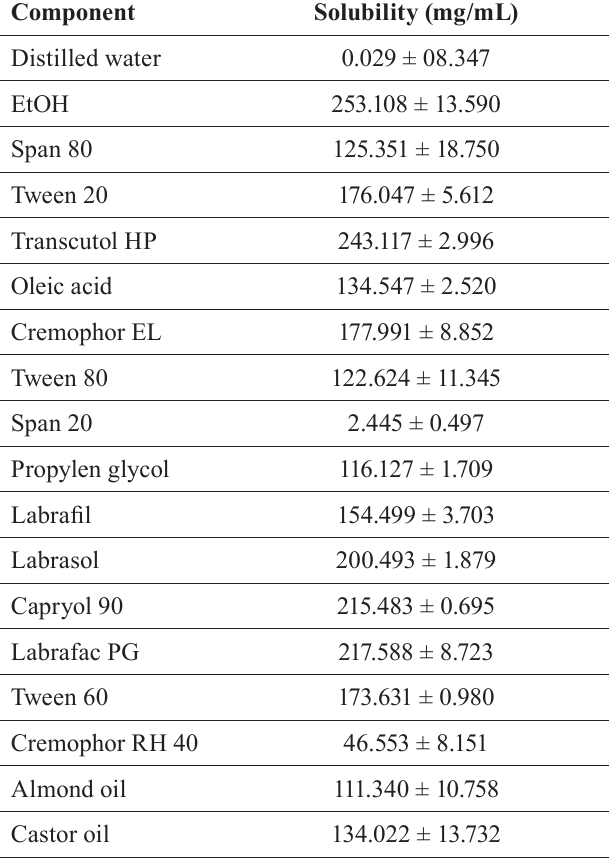
TABLE II - Solubility of ETF in different surfactants, co- surfactants, and